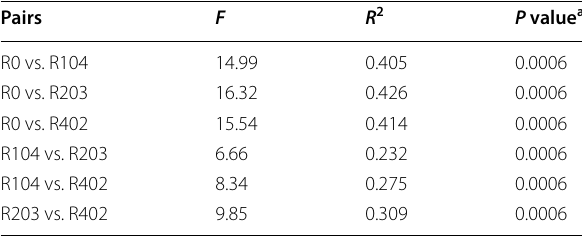
Table 2 PERMANOVA pairwise comparisons of microbial community composition between the wells